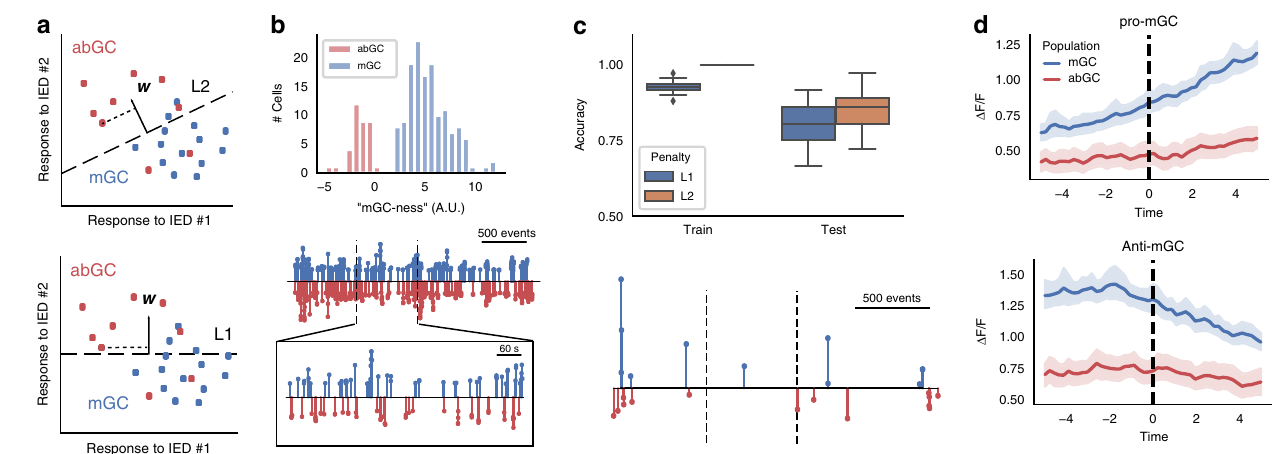
Fig. 3 Linear classi fi er shows differential participation of abGC and mGC populations during interictal spikes. Individual IEDs preferentially recruit abGC (red) or mGC (blue) neurons ( “ preferred ” = positively modulated). a Schematic of L1 and L2 embedding/classi fi cation procedure. Logistic regression projects the “ response fi ngerprint ” of every cell down to a maximally separating line in spike-response space ( w ). L1 regularization introduces sparsity to w , selecting the fewest events necessary to perform accurate classi fi cation. b Top: The 1D projection as an “ mGC-ness ” score (top histogram). Middle: The embedding weights (stem plot, A.U.), plotted by event number over a 30 min recording session. Expansion: IEDs in the middle 10 min of the session, plotted across time. c Logistic regression with L1 ( “ lasso ” ; blue) regularization reveals a sparse subset of interictal spikes that is “ most informative ” about cell identity. Top: 100 times cross-validation on an 80 – 20 train-test split shows 85 ± 5% classi fi cation accuracy on the test set under standard L2 (orange) regularization and 81 ± 5% classi fi cation accuracy under L1 regularization, implying that a small subsets of IEDs are associated with either mGC or abGC activation, such that cell activity within these events alone is suf fi cient to accurately predict cell identity. Center line, median; box limits, upper and lower quartiles; whiskers, 1.5× interquartile range. Bottom: Similar to b , weights associated with “ most informative ” events (A.U.) identi fi ed from lasso classi fi er plotted vs. event number over three back-to-back recording sessions (vertical dashed lines). Events that are predictive of mGC identity, termed “ pro-mGC ” events, are colored in blue, while events where mGCs tend to exhibit negative responsiveness or abGCs tend to exhibit positive responsiveness are termed “ anti-mGC ” events, and are colored in red. See Fig. S2 for comparison across animals. d PSTHs triggered on pro-mGC (left) and anti-mGC (right) IEDs for an example mouse. Pro-mGC IEDs positively modulate mGCs, while anti-mGC events negatively modulate mGCs (right, in blue). In contrast, abGCs do not appear to be signi fi cantly modulated in either direction by either event type (data presented as mean value + / − 95%